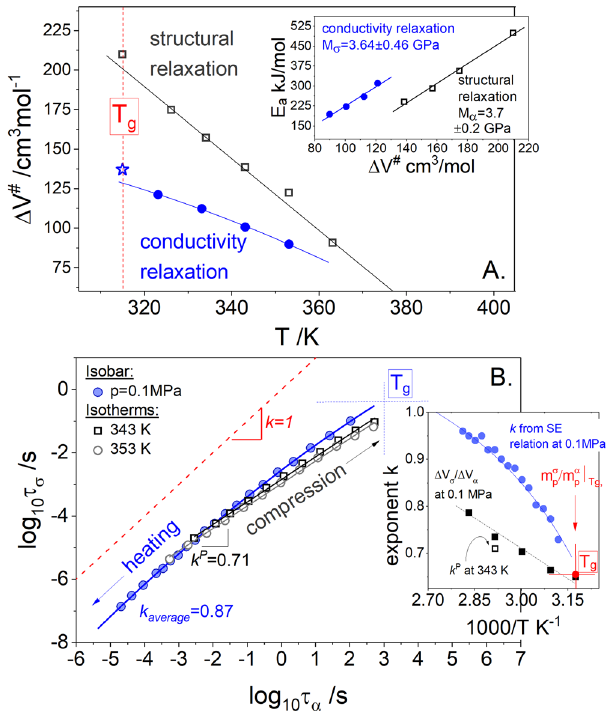
Figure 5. ( A ) Activation volume of structural relaxation and conductivity relaxation as a function of temperature. The ∆ V # value at T g was determined from Eq. 4 (stars). Inset panel presents the dynamic modulus calculated for structural and conductivity relaxation processes. ( B ): Test of the fSE at ambient and elevated pressures for ACB-HCl. Inset: the fractional exponent k as a function of reciprocal temperature compared to calculated m p σ /m p α and ∆ V # σ / ∆ V # α